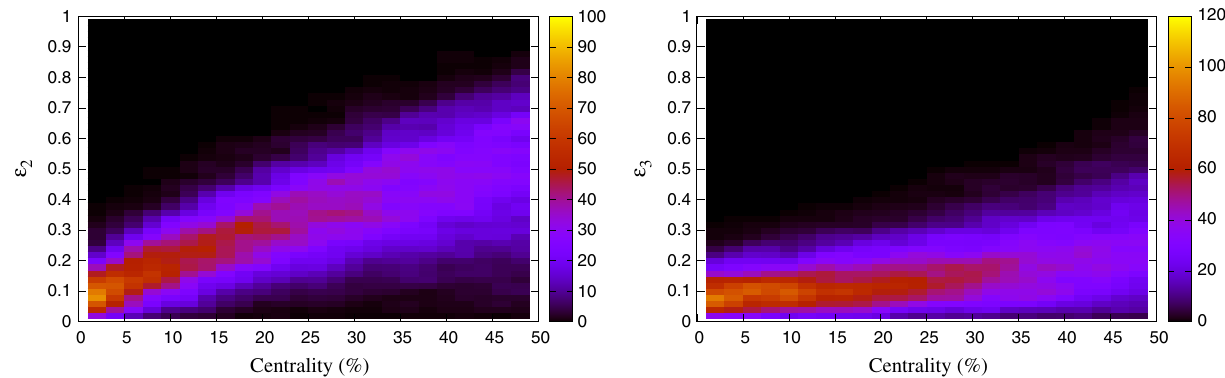
Fig. 2 Correlation between the elliptic (left panel) and triangular (right panel) eccentricity and the centrality of the nucleus–nucleus collisions for our Glauber-MC sample of Pb–Pb events − (cid:7) 2 one gets (cid:6) N coll (cid:7) high N